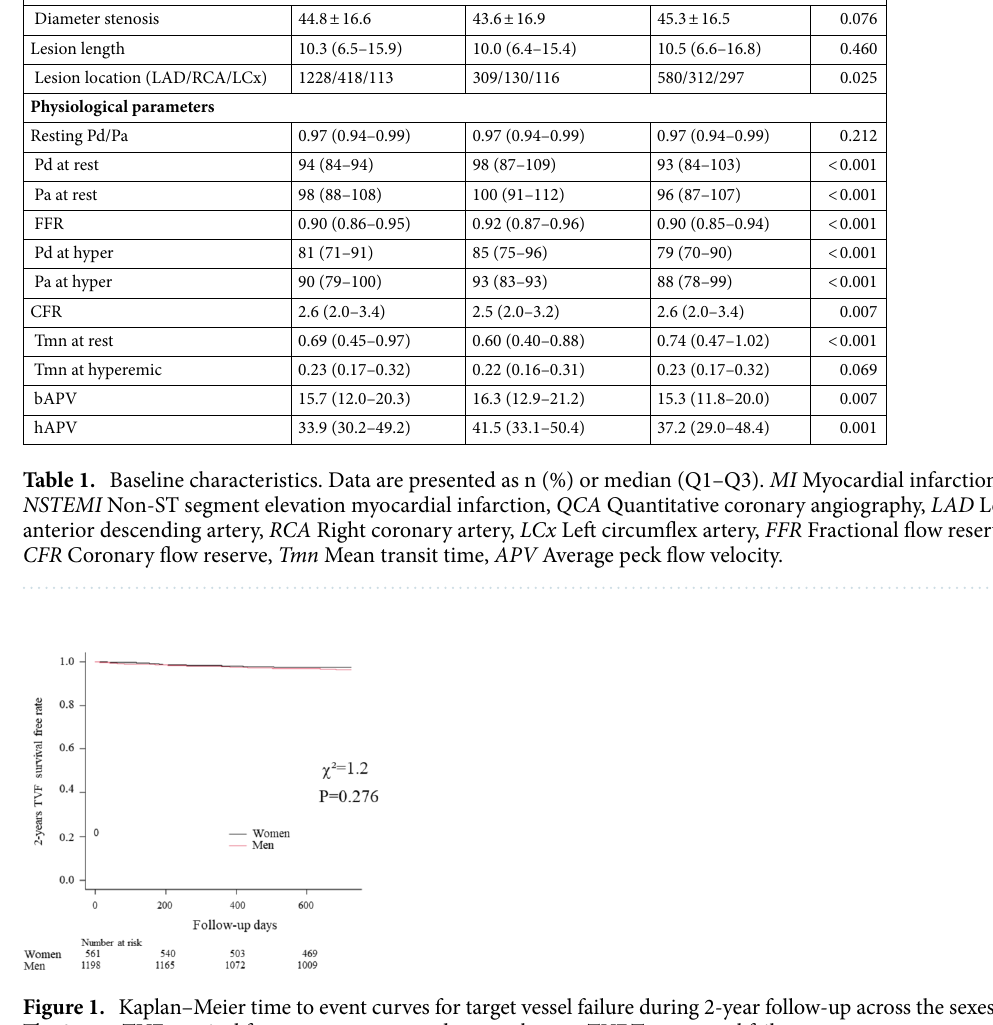
Pa during 2 years of follow-up. In the risk comparison analyses, women with abnormal resting Pd/Pa showed the highest risk of 2-year TVF. Women with abnormal resting Pd/Pa compared with normal one showed a hazard ratio of 9.79 (Fig. 2, 95% CI 3.43–27.93; p < 0.001). Seven women with abnormal resting Pd/Pa underwent 2-year TVF. (3 acute MI and 4 TVF). Figure 3A depicts the Kaplan–Meier curves for 2-year TVF across the groups defined by normal and abnor- mal resting Pd/Pa and CFR in patients in whom revascularization was deferred following FFR measurements. Concordant abnormal resting Pd/Pa and CFR group carried the highest risk for TVF, while in a subgroup analysis for each sex, these two indices were identified as independent predictors of 2-year TVF only for women. (Fig. 3B and 3C) These results were consistent with per-patient analyses. (Supplemental Figure 3 and 4.) ROC analyses also revealed differences between the sexes in the prognostic values of these measures. In women, compared with the clinical model 1 (AUC: 0.665), the model accuracy for 2-year TVF tended to increase with the addition of CFR (model 2, AUC: 0.744; p = 0.083). The model accuracy was further improved when